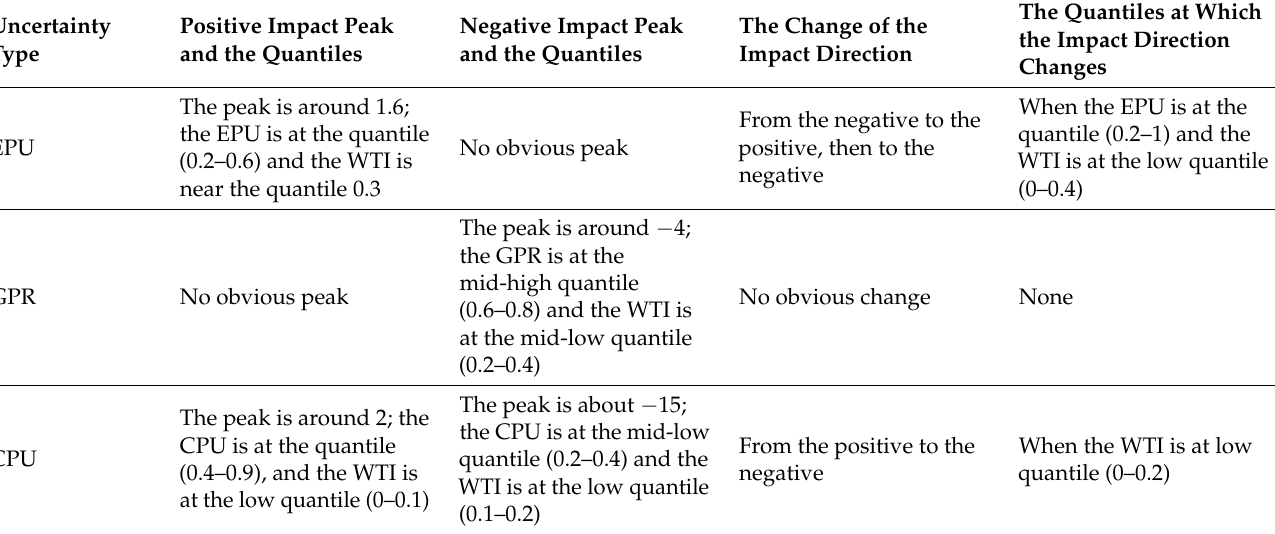
Table 6. Comparison of the overall impacts of three uncertainty indexes on crude oil